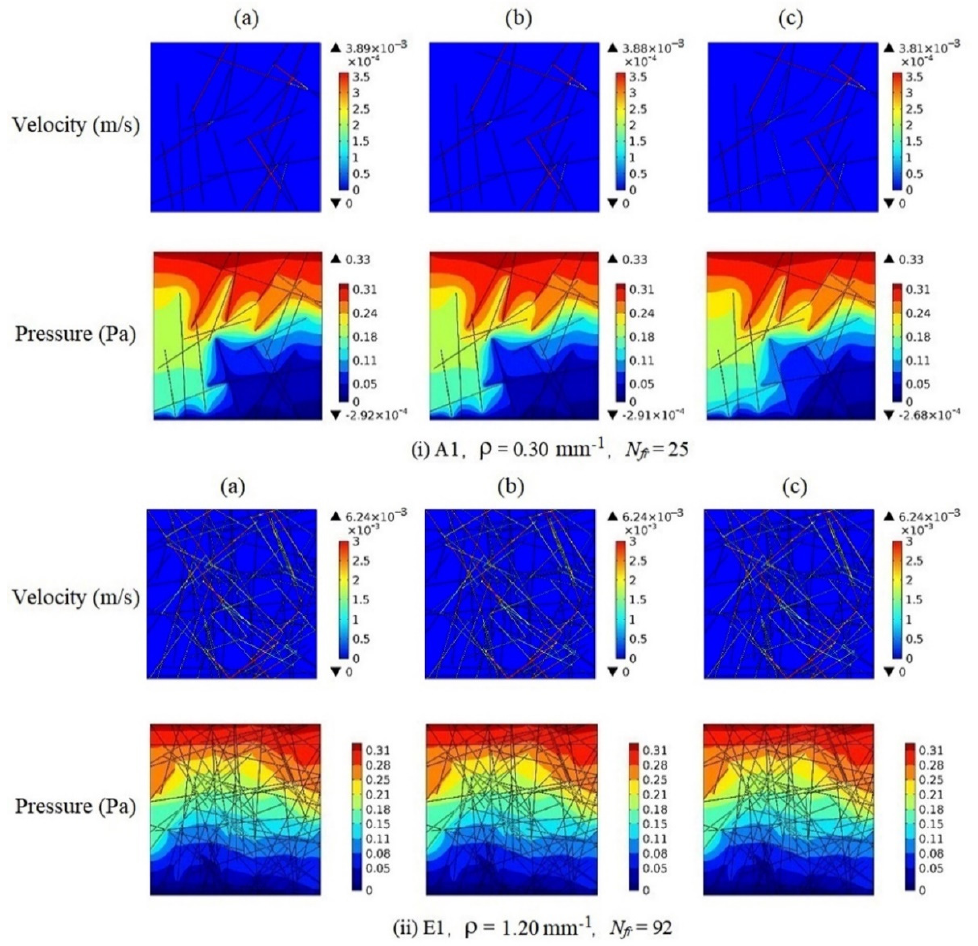
Figure 8. Velocity fields (top row) and pressure profiles (bottom row) in the selected fracture systems from three different matrix properties: ( a ) I rock ; ( b ) II rock ; ( c ) III rock . The high-velocity branches plot the clear hydraulic paths, which consist of several connected fracture clusters. The pressure profiles show a slight pressure gradient in the fractures and matrices due to different fracture distributions and matrix properties.